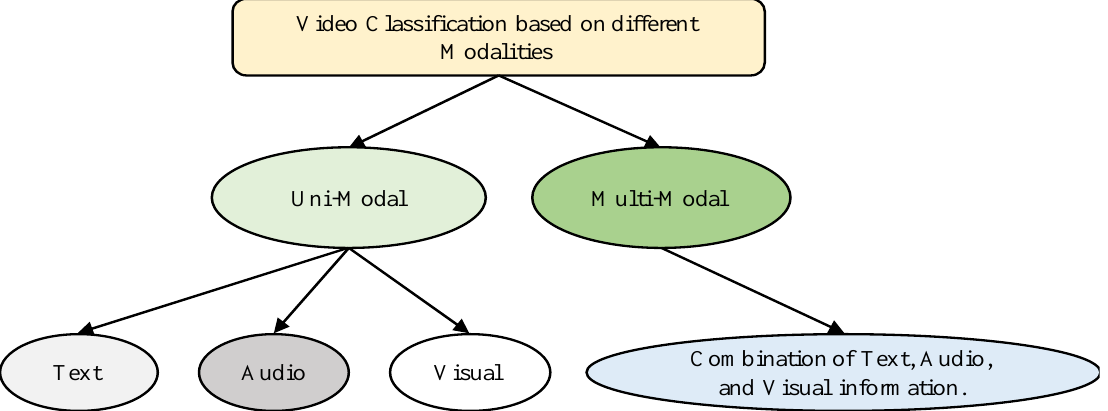
Figure 2. Different modalities used for classification of videos.